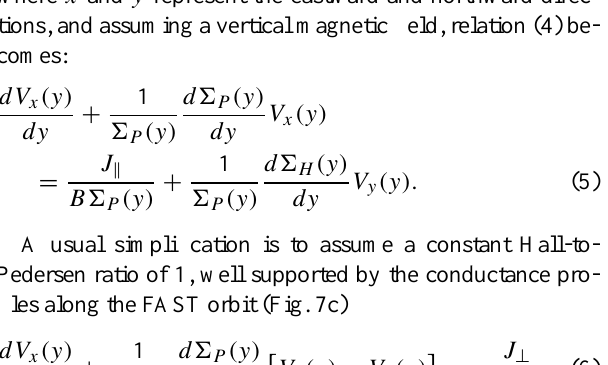
Fig. 8. Inputs (a and b) and result (c) parameters of the 1-D simulation along the FAST orbit. (a) Ionospheric Peder- sen conductance. (b) Field-aligned cur- rent measured by FAST. (c) Modelled (solid) and experimental (dotted line) east-west convection velocity. Dotted lines delineate the three parallel current sheets and the dashed line indicates the velocity